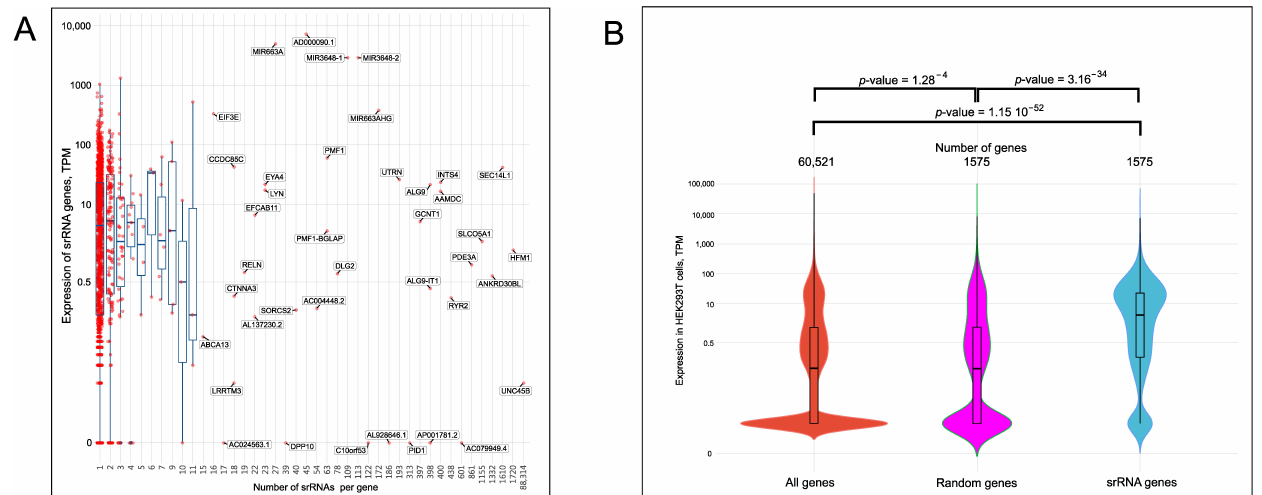
Figure 4. Analysis of expression of srRNA target genes. ( A ) The scatter plot presents the expression levels of 1584 srRNA target genes and the numbers of corresponding srRNAs. The red dots indicate srRNA target genes. The median position and whiskers are shown in blue. The X -axis is not to scale. The list of all srRNAs is shown in Table S1. The names of genes are indicated if a single gene is targeted by a particular set of isolated srRNAs (see Section 4). ( B ) Violin plots showing the distribution of genes with respect to their expression levels for all HEK293T genes (red), random genes (violet), and srRNA target genes (blue). The numbers of corresponding genes are shown at the top.